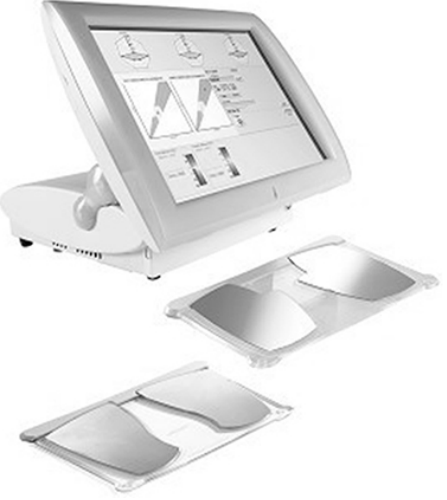
Figure 1. SUDOSCAN medical device—general presentation.